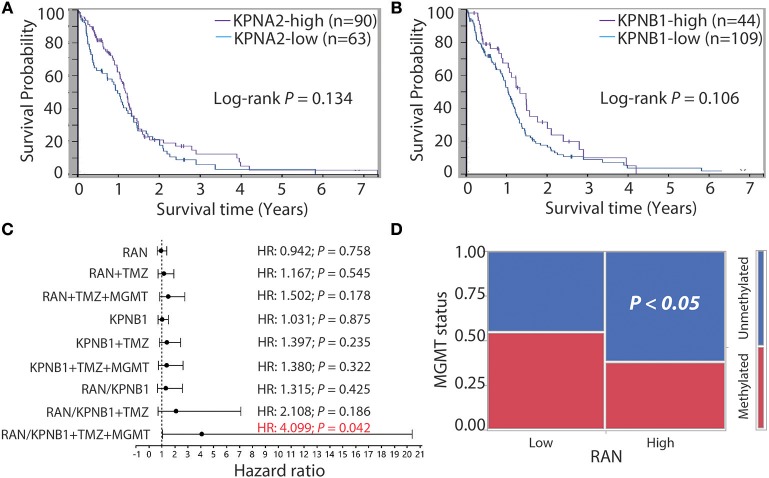
GBM patients with more RAN and KPNB1 exhibit MGMT-dependent TMZ resistance and have shorter life expectancies. Survival curves of GBM patients with different levels of KPNA2 (A) or patients with different levels of KPNB1 (B) were retrieved from the Human Protein Atlas. Log-rank P-values are shown. (C) Cox univariate and multivariate analyses of GBM patients with different levels of RAN and/or KPNB1. Data were retrieved from the TCGA database and re-analyzed using JMP software. Hazard ratios (HRs) that determine chances of death are shown. P-values indicate the statistical significance of HRs. TMZ treatment (TMZ) and promoter methylation status of MGMT (MGMT) were used as covariates. (D) MGMT promoter methylation in GBM patients expressing different levels of RAN. P < 0.05 indicates that GBM patients with high levels of RAN often have an unmethylated MGMT promoter.